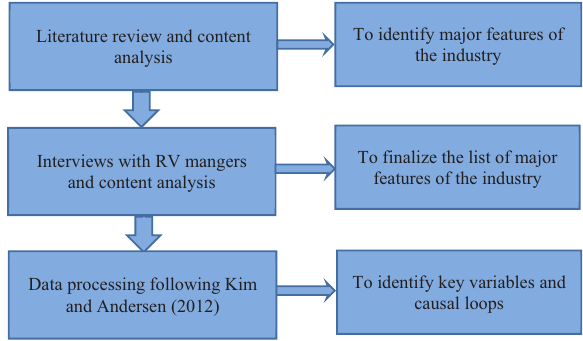
Figure 1. Research process for the development of the causal loop